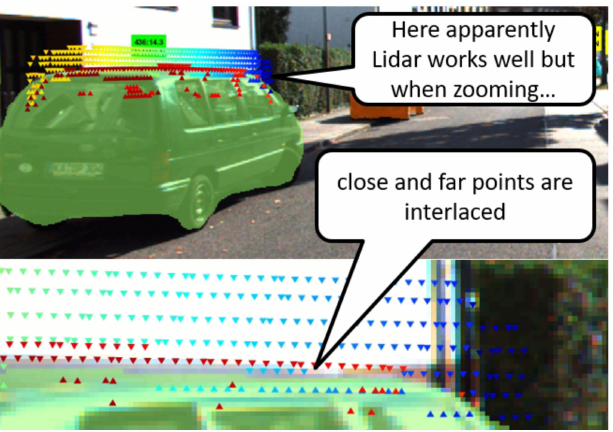
Figure 1. Examples of location errors in data provided by LiDAR. The color represents the distance.